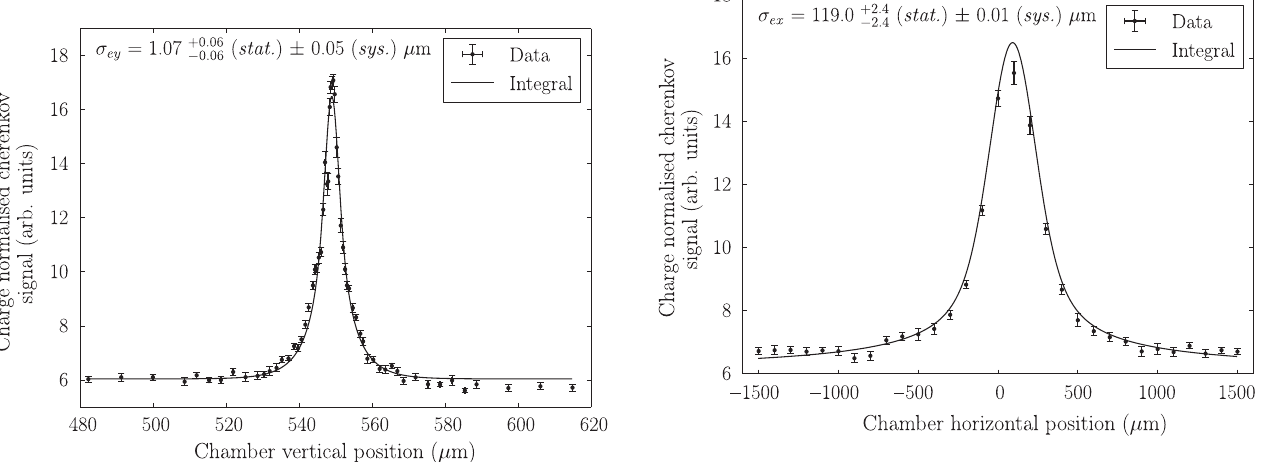
FIG. 19. Nonlinear step size laserwire scan with the smallest measured electron beam size.